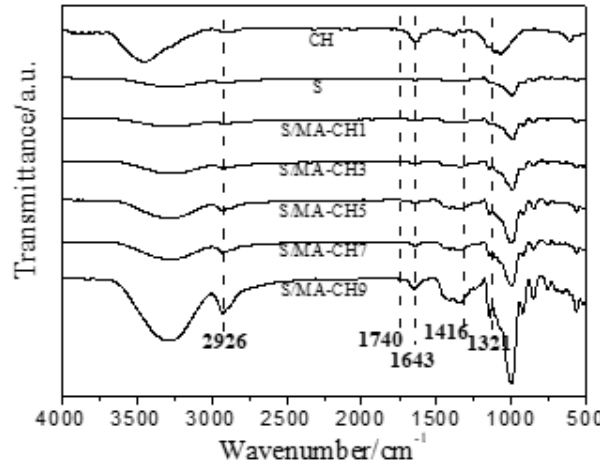
Figure 2. ATR-FTIR spectra of chitin nanoparticle (CH), starch films (S), S / CH 1% films, S / CH 3% films, S / CH 5% films, S / CH 7% films, S / CH 9%, S / MA-CH 1% films, S / MA-CH 3% films, S / MA-CH 5% films, S / MA-CH 7% films, and S / MA-CH 9% films.